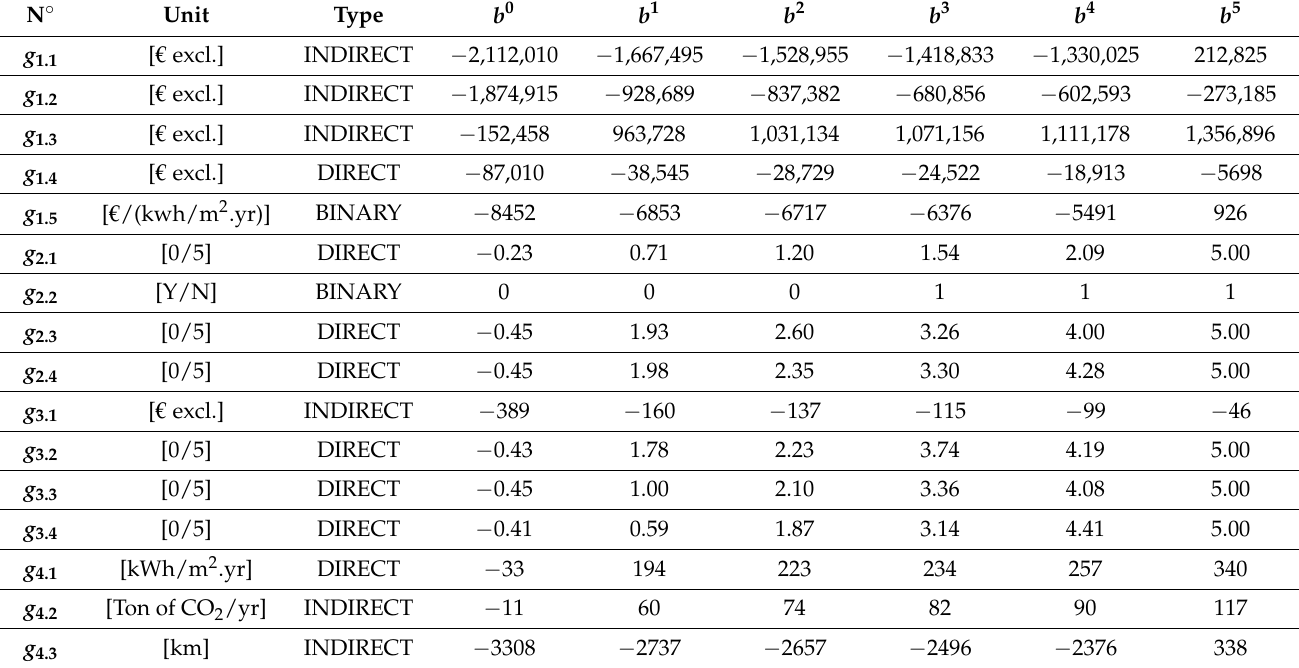
Table 13. Definitions of the characteristic